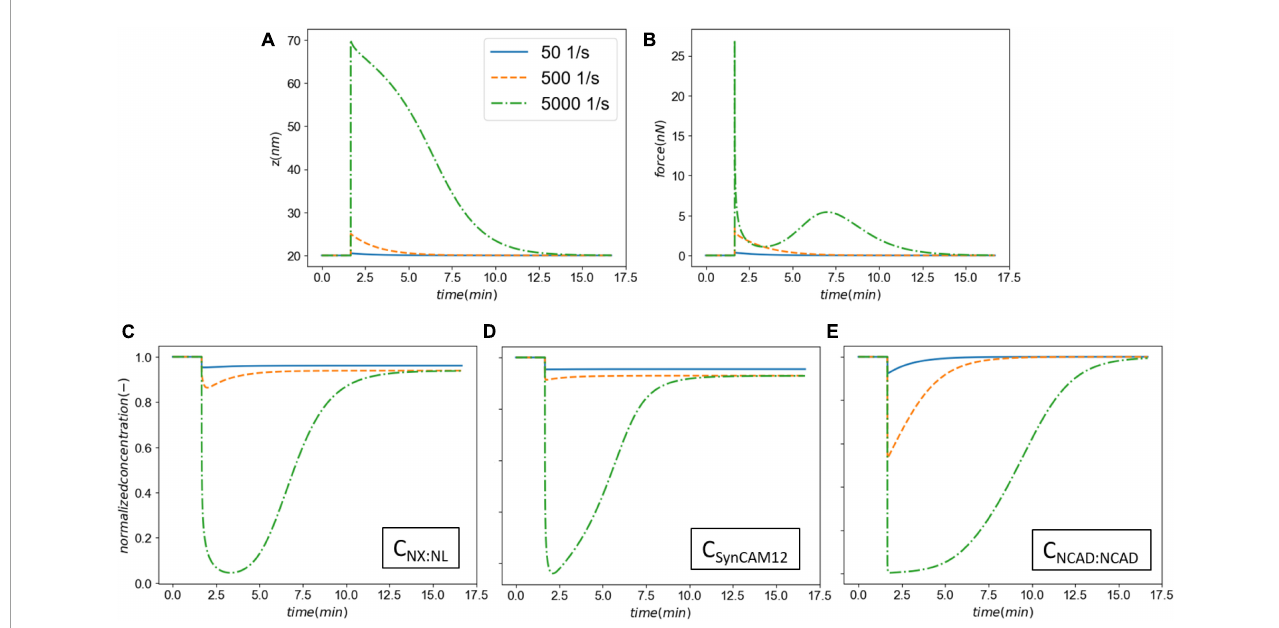
FIGURE5 The effect the strain rate on the synaptic cell adhesion molecules (CAM) mechanics and concentrations. Panel (A) shows the cleft size before, during and after the insult. Panel (B) shows the total force applied on the intermolecular bonds. Panels (C–E) show the normalized CAM complex concentrations for NX:NL, SynCAM12, and NCAD:NCAD,